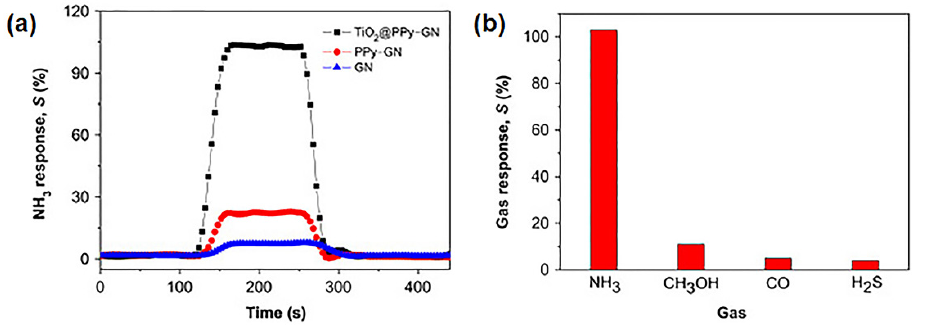
Figure 4. ( a ) Gas response of GN, PPy/GN, and TiO 2 /PPy/GN samples to NH 3 (50 ppm) at room temperature; ( b ) Response of TiO 2 /PPy/GN nanocomposite to different gases at a fixed concentration of 50 ppm. Reproduced with permission from Xiang et al., Ceram. Int.; published by Elsevier, 2015 [26] .